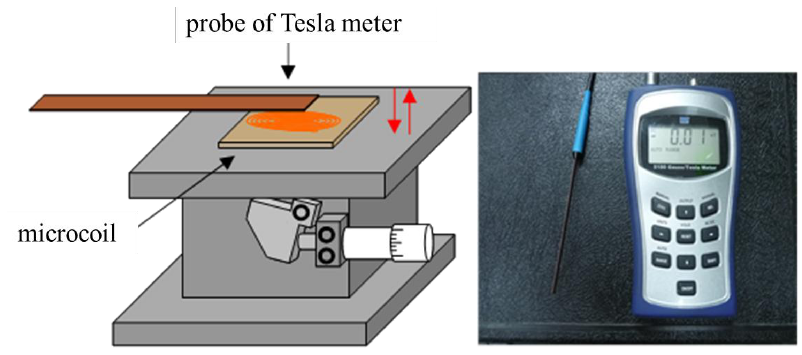
Figure 4. Measurement instrument set-ups of ( a ) flux density, ( b ) electromagnetic force and ( c ) membrane